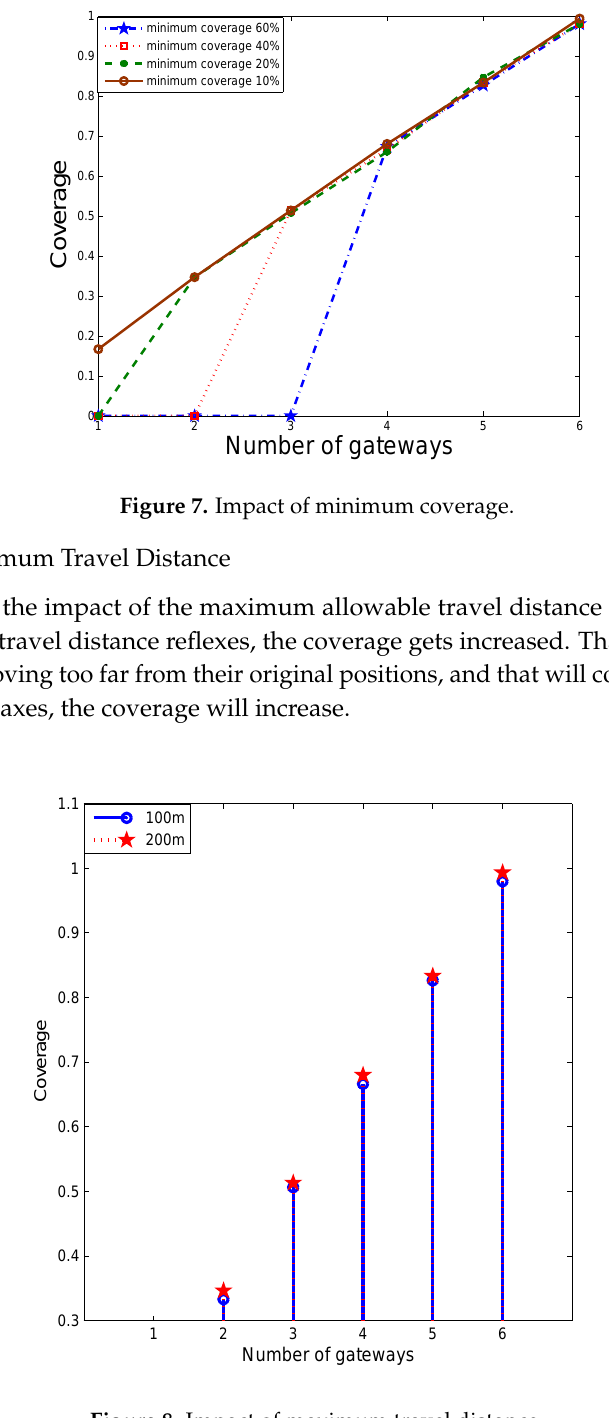
Figure 8. Impact of maximum travel